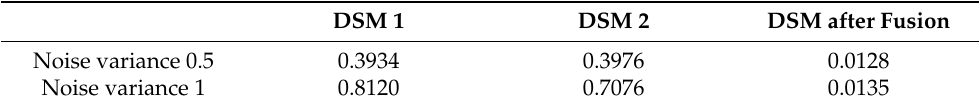
Figure 6. Comparison of the effect before and after the fusion of four-slope-roofed buildings with different variance Gaussian noise. ( a ) DSM of the truth map for four-slope-roofed building. ( b ) DSM 1 variance 0.5. ( c ) DSM 2 variance 0.5. ( d ) DSM after fusion variance 0.5. ( e ) DSM 1 variance 1. ( f ) DSM 2 variance 1. ( g ) DSM after fusion variance 1. Table 1. Comparison of elevation errors before and after fusion of flat-roofed buildings.